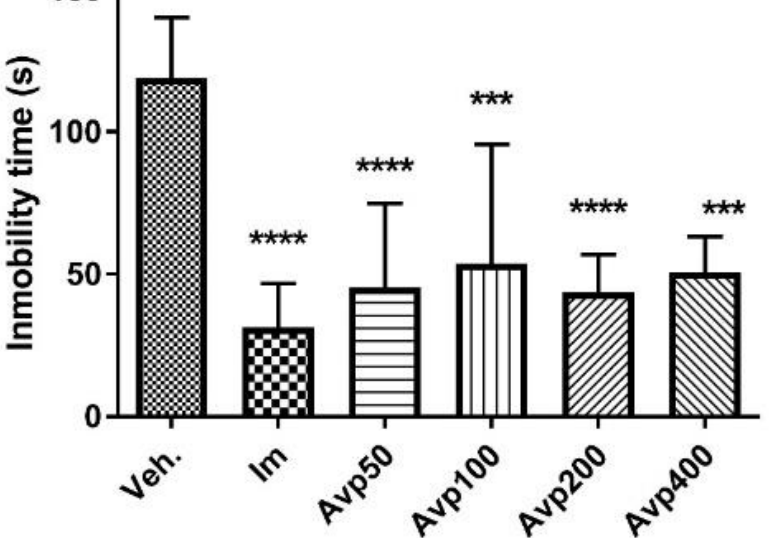
Figure 7. Immobility time (s) in the forced swimming test for the groups ( n = 6) treated orally with three doses in a 24-h period of Aloysia virgata var. platyphylla (Avp). Im.: imipramine. Veh: tween 80, 10%. The data correspond to the mean ± SD. One-way ANOVA and Dunnett’s post hoc test were performed. *** p < 0.001; **** p < 0.0001.